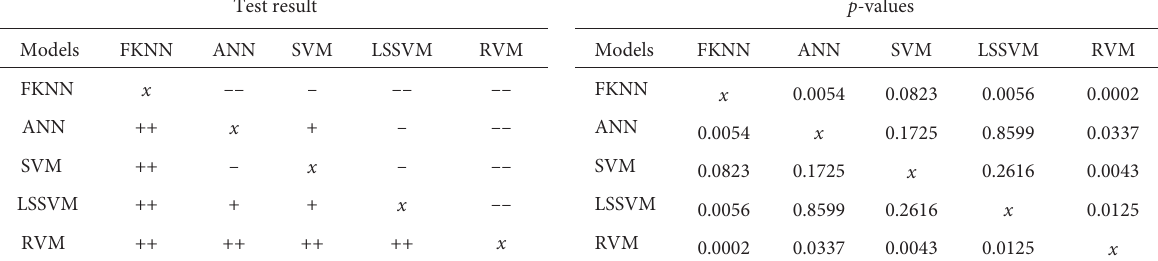
Figure 6: Performance comparison of the five soil erosion prediction models using Wilcoxon signed-rank